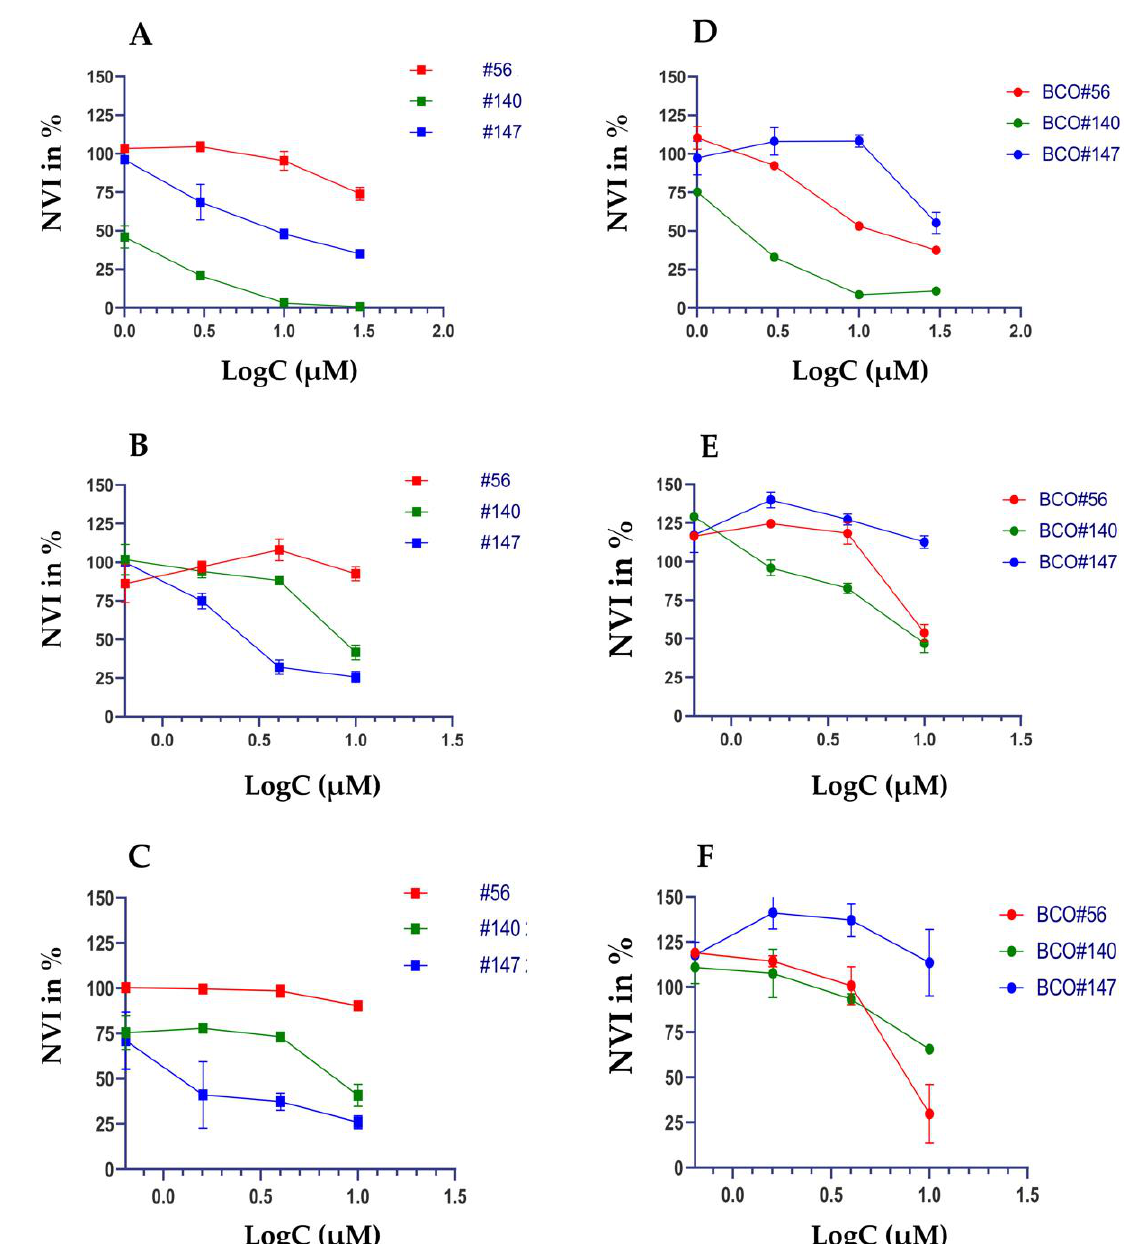
Figure 5. Comparing cytotoxic effects in urothelial carcinoma cells in 2D versus 3D cultures. BCOs were generated from cells of patients #56, #140, and #147 and expanded. From BCOs, cells were derived for further expansion in adherent 2D cultures ( A – C ) or 3D organoid cultures ( D – F ). The CTG chemiluminescence assay in 2D (left panel) vs. 3D (right panel) cultures was performed to compare the responses of the cells to CIS ( A , D ), VTX ( B , E ), and S63 ( C , F ), respectively. The mean normalized viability index in percent (NVI %; ordinate, Y-axis) is disclosed as function of the logarithm of drug concentrations employed (LogC; (µM), abscissa, X-axis).